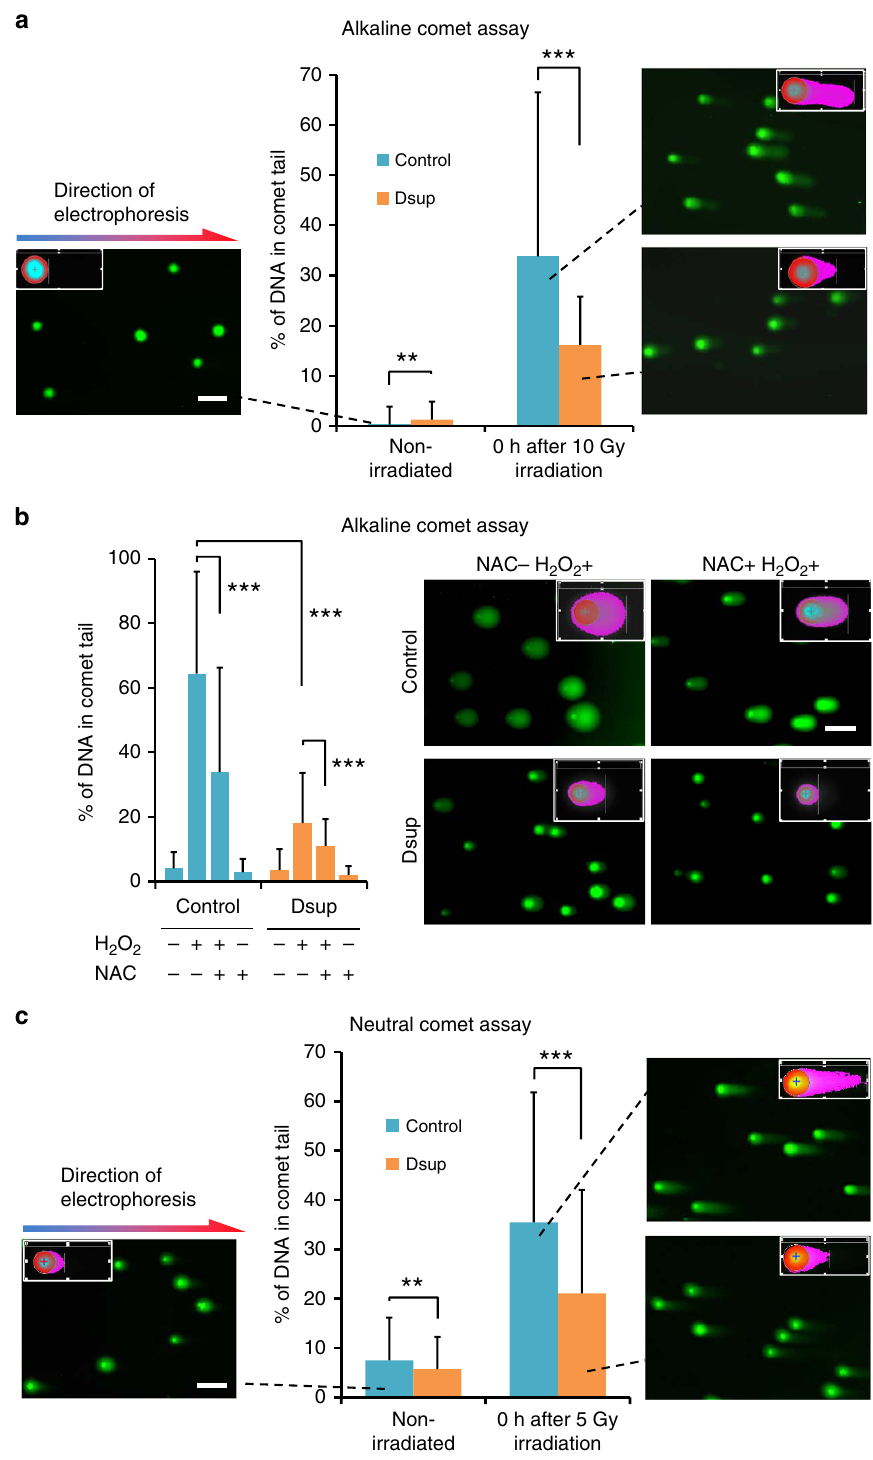
Figure 4 | Dsup protein suppresses stress-induced DNA fragmentation in human cultured cells. ( a ) The effects of Dsup on SSBs by 10Gy X-ray irradiation in alkaline comet assays. The irradiated cells were immediately subjected to the assay. Representative images are shown for each condition. In the pseudo-coloured images in the inset, red to blue circles indicate nuclear DNA and magenta indicates fragmented DNA in tail. DNA fragmentation was assessed by the proportion of DNA detected in the tail region (% of DNA in Comet Tail). At least 281 comets were analysed for each condition. ** P o 0.01 and *** P o 0.001 (Welch’s t -test: non-irradiated, t -value ¼ (cid:2) 3.199, P -value ¼ 0.0015; irradiated: t -value ¼ 8.599, P -value o 1.0 E (cid:2) 15). ( b ) The effects of Dsup on SSBs caused by hydrogen peroxide (H 2 O 2 ) treatment in alkaline comet assays. Cells were treated with 100 m M H 2 O 2 for 30min at 4 (cid:2) C, to induce DNA damage with or without pretreatment with 10mM NAC as an antioxidant for 30min. At least 203 comets were analysed for each condition. *** P o 0.001 (Tukey–Kramer’s test). ( c ) The effects of Dsup on DSBs by 5Gy X-ray irradiation in neutral comet assays. Three hundred comets were analysed for each condition. ** P o 0.01 and *** P o 0.001 (Welch’s t -test: non-irradiated, t -value ¼ 2.758, P -value ¼ 0.0060; irradiated; t -value ¼ 7.406, P -value ¼ 4.7 E (cid:2) 13). Values represent mean ± s.d. in all panels. Scale bars, 100 m m. NATURE COMMUNICATIONS|7:12808|DOI: